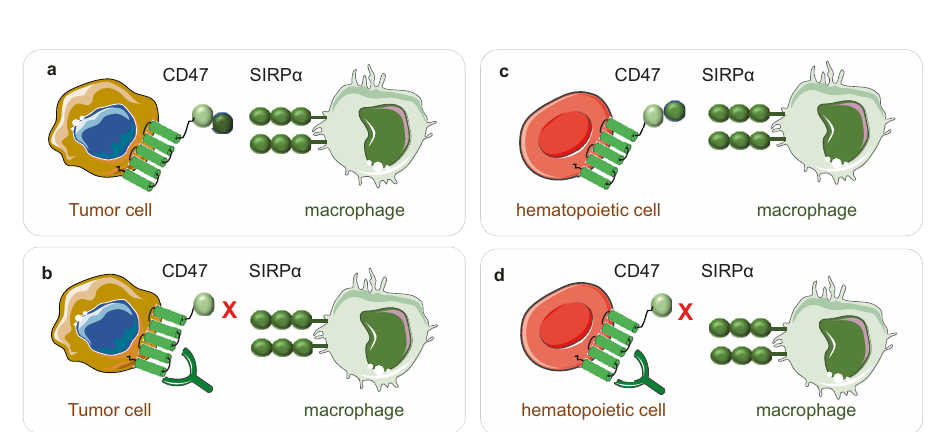
Fig. 5 Mechanisms of phagocytosis checkpoints. a CD47 on the surface of tumor cells binds to SIPR α on the membrane of the macrophage. This interaction promotes the phosphorylation of ITIM in SIRP α by Src family kinases SHP-1 and SHP-2. The recruitment of SHP-1 and SHP-2 phosphorylate myosin IIA, then suppresses the function of non-muscle myosin IIA, upon dephosphorylation of Myosin IIA in macrophages, the de-polymerization of actin occurs, resulting in the limitation of phagocytosis. b TP53 mutation increases the expression of PD-L1 on extracellular vesicles, leading to the block of phagocytosis of tumor cells by macrophages. c The β 2M of MHC-1 binds to the extracellular region of LILRB1 to form a complex with the MHC- I heavy chain, this novel inhibitory MHC-I-LILRB1 axis inhibits the innate immune system. d The inhibitory receptor Siglec-10 on the macrophage surface binds to its ligand CD24 on cancer cells, resulting in an ITIM or ITIM-like motif in the cytoplasmic domain of Siglec-10 combing with Src family kinases. Then Src family kinases phosphorylate ITIM tyrosine in the cytoplasm, then recruit SHP-1/ SHP-2. SHP-1 can speci fi cally bind to the intracellular phosphorylated ITIM domain to dephosphorylate it, leading to cytoskeleton remodeling and phagocytosis inhibition. e STC-1 interacts with the “ eat me ” signal calreticulin and abrogates the membrane calreticulin-directed phagocytosis by macrophages, thus impairing the antigen presentation from macrophages to T cells. Tumor STC-1 is crucial for intrinsic tumor resistance to tumor immunity, it traps calreticulin in mitochondria and ER to inhibit macrophage function and facilitate the tumor cell immune evasion and immunotherapy resistance. f GD2 (generated by the enzyme B4GALNT1) binding the Siglec-7 (the inhibitory immunoreceptor) on phagocyte triggers “ don ’ t eat me ” signals in the macrophages, calreticulin is an “ eat me ” signal on the surface of tumor cells, the ligation of